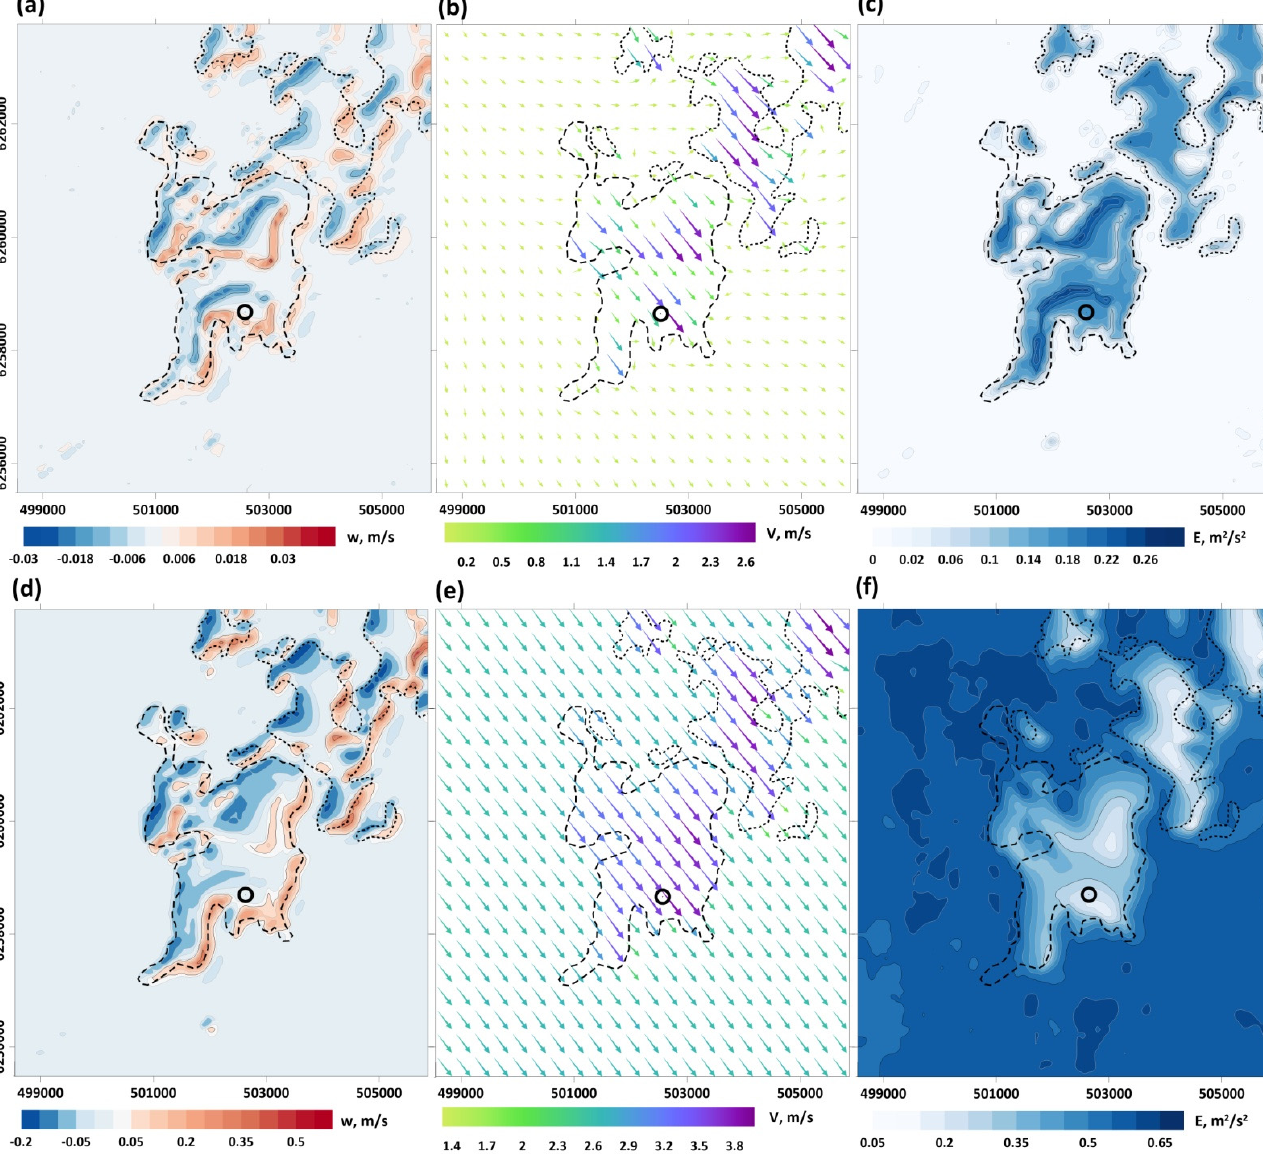
Figure 5. Modeled vertical ( a , d ) and horizontal ( b , e ) flow velocity, and turbulent kinetic energy ( c , f ) distributions at the heights of 3 ( a – c ) and 30 ( d – f ) m above the ground. Calculations were performed using meteorological data at 13:30 on 28 June 2016. The wind direction at the upper boundary of the modeling domain is northwest. The medium-dashed line shows the peatland boundary. The short-dashed line shows the boundaries of abandoned lands with grassy vegetation and open places. The black circle indicates the location of the eddy covariance flux station. Negative vertical flow component corresponds to the downward air flows, and positive − to the upward ones. Coordinate system is Universal Transverse Mercator (UTM, 36N).